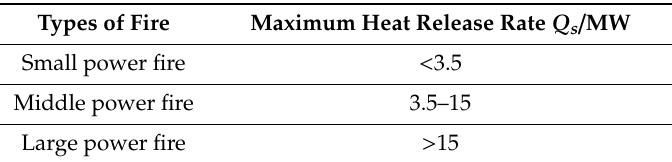
Table 1. Types of heat release rate.